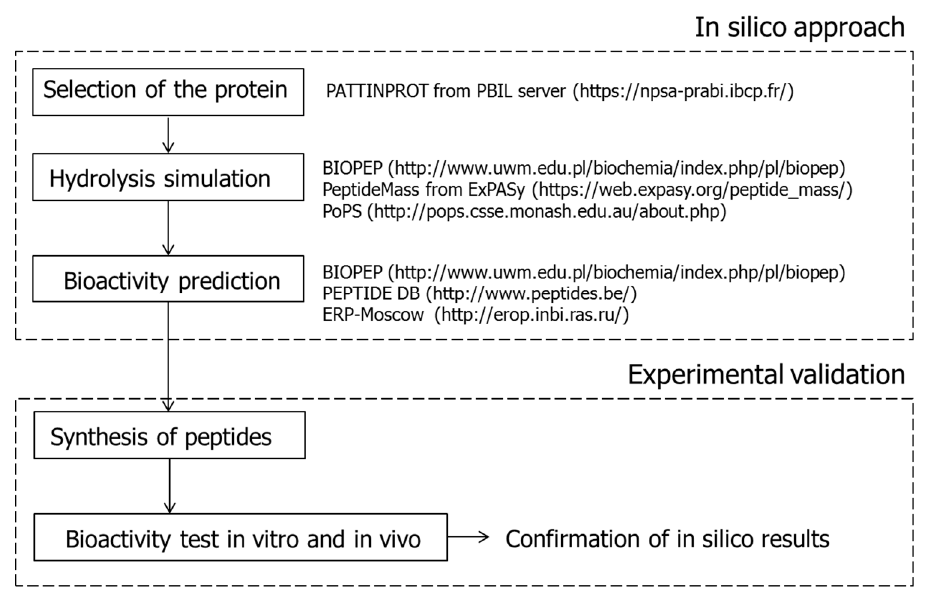
Figure 4. Main steps of in silico approaches and open access databases for the selection of the protein, hydrolysis simulation and bioactivity prediction.